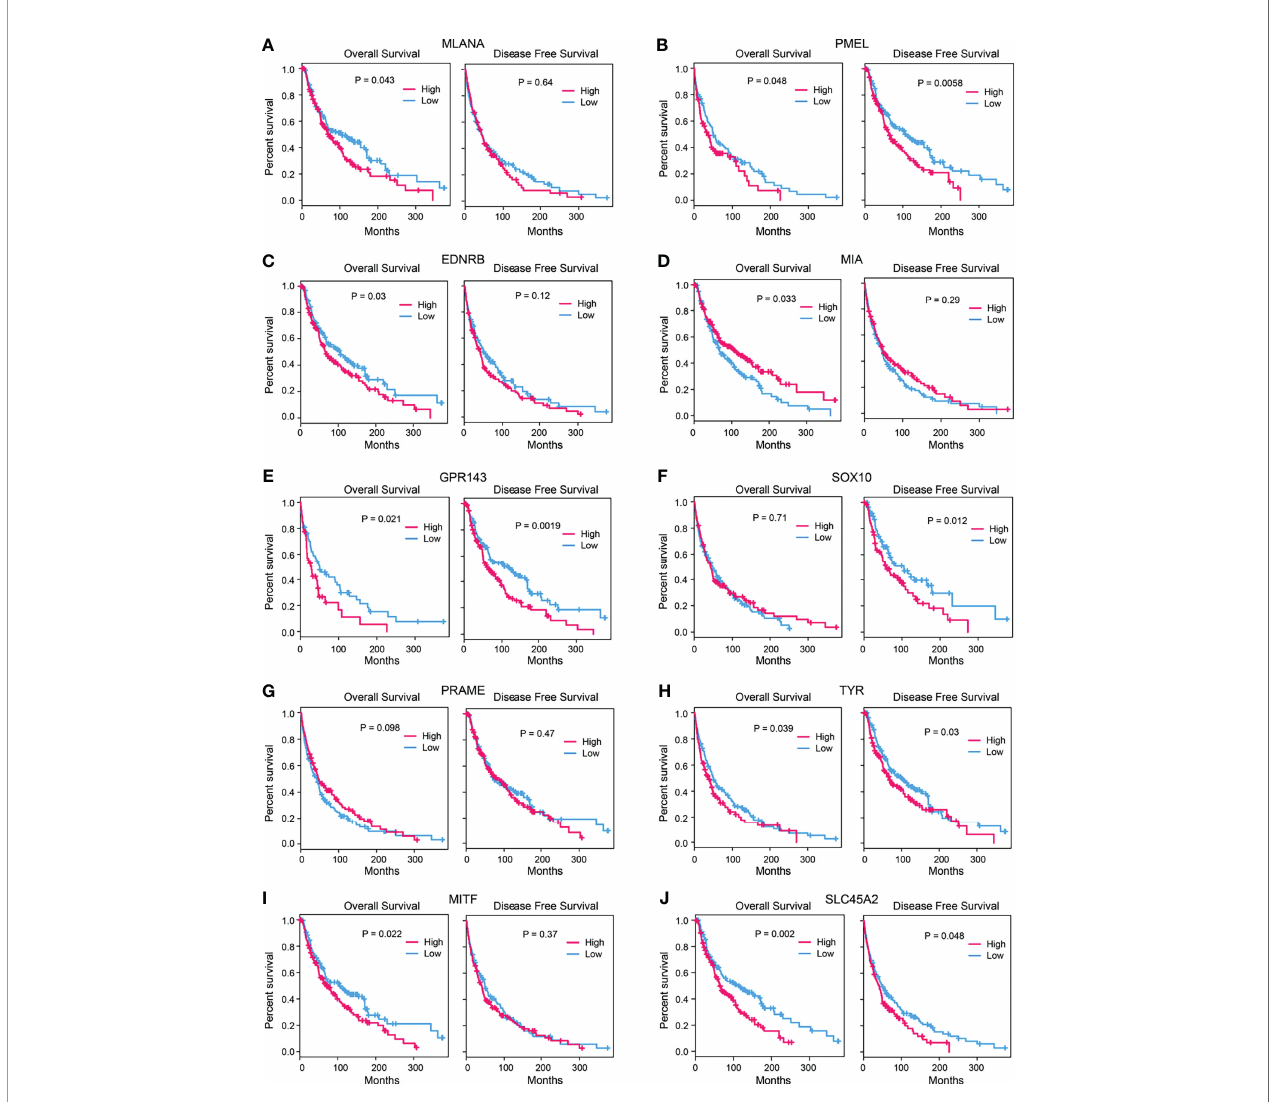
FIGURE 5 | Survival analysis of candidate genes. Correlation between the expression levels of candidate genes (A) MLANA , (B) . PMEL , (C) EDNRB , (D) MIA , (E) GPR143 , (F) SOX10 , (G) PRAME , (H) TYR , (I) MITF , and (J) SLC45A2 and the survival rates (left: overall survival, right: disease-free survival) of the SKCM patients ( p -value: log-rank